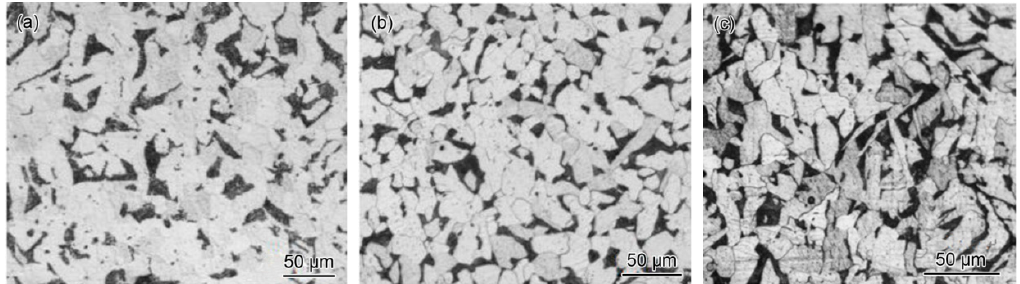
Figure 1. Microstructures of pipes with different diameters: ( a ) 2 ″ , ( b ) 4 ″ , and ( c ) 6 ″ .